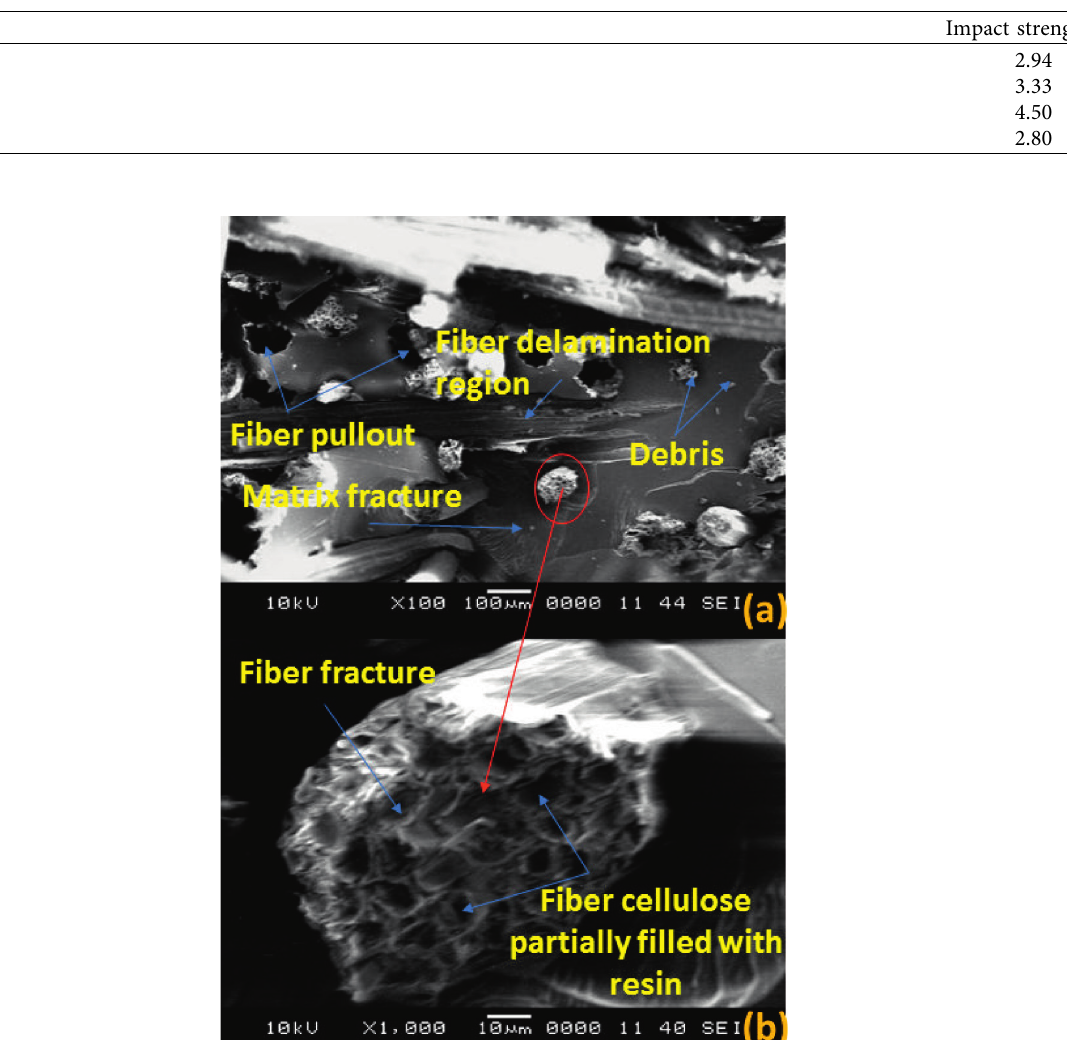
Table 6: Impact test results.